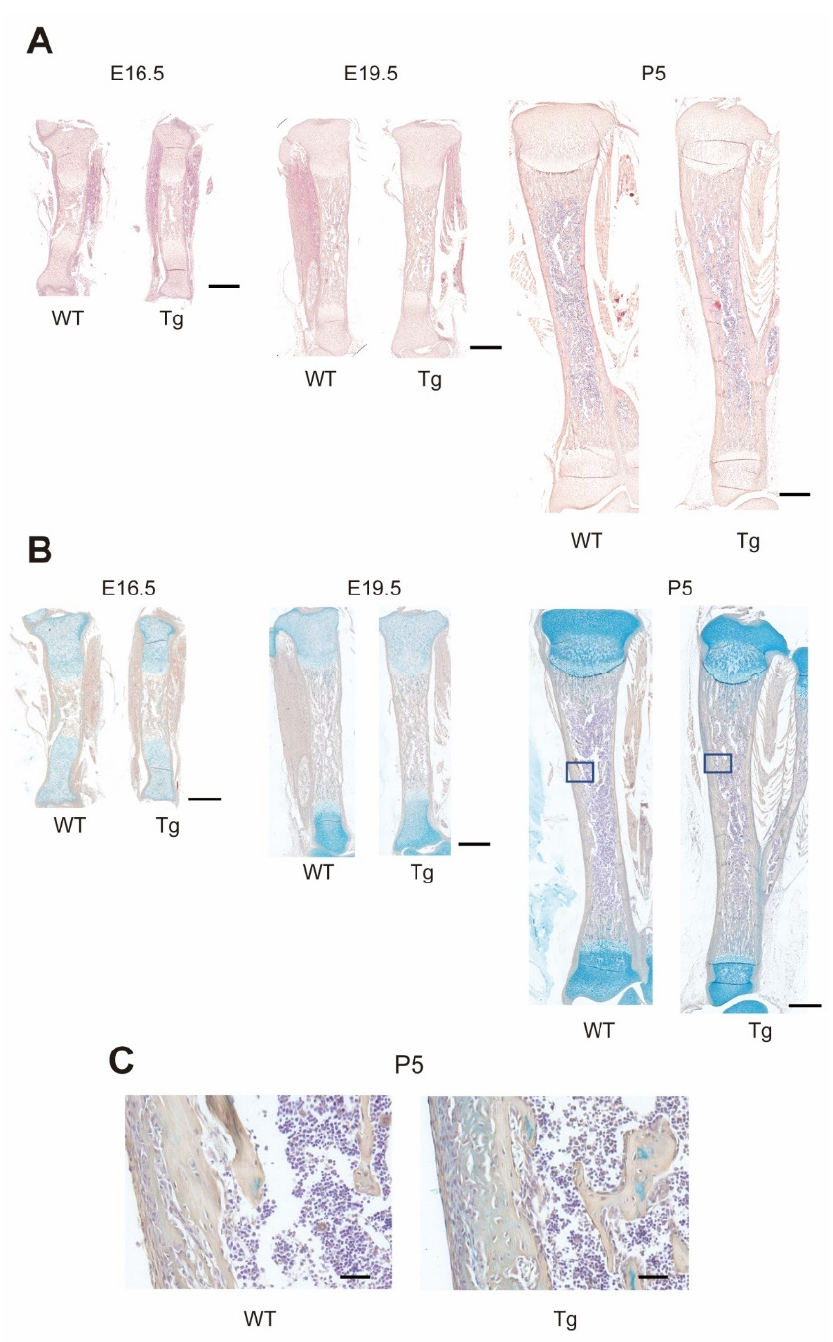
Figure 1. Longitudinal growth of Tg and WT tibiae during the peripartum period. ( A , B ) Represen- tative images of longitudinal sections of tibiae at E16.5–P5, stained with hematoxylin-eosin (H-E) ( A ) and hematoxylin and Alcian blue ( B ). Scale bars, 500 µ m. ( C ) High magnification images of the boxed areas (P5) in panel ( B ). Scale bars, 80 µ